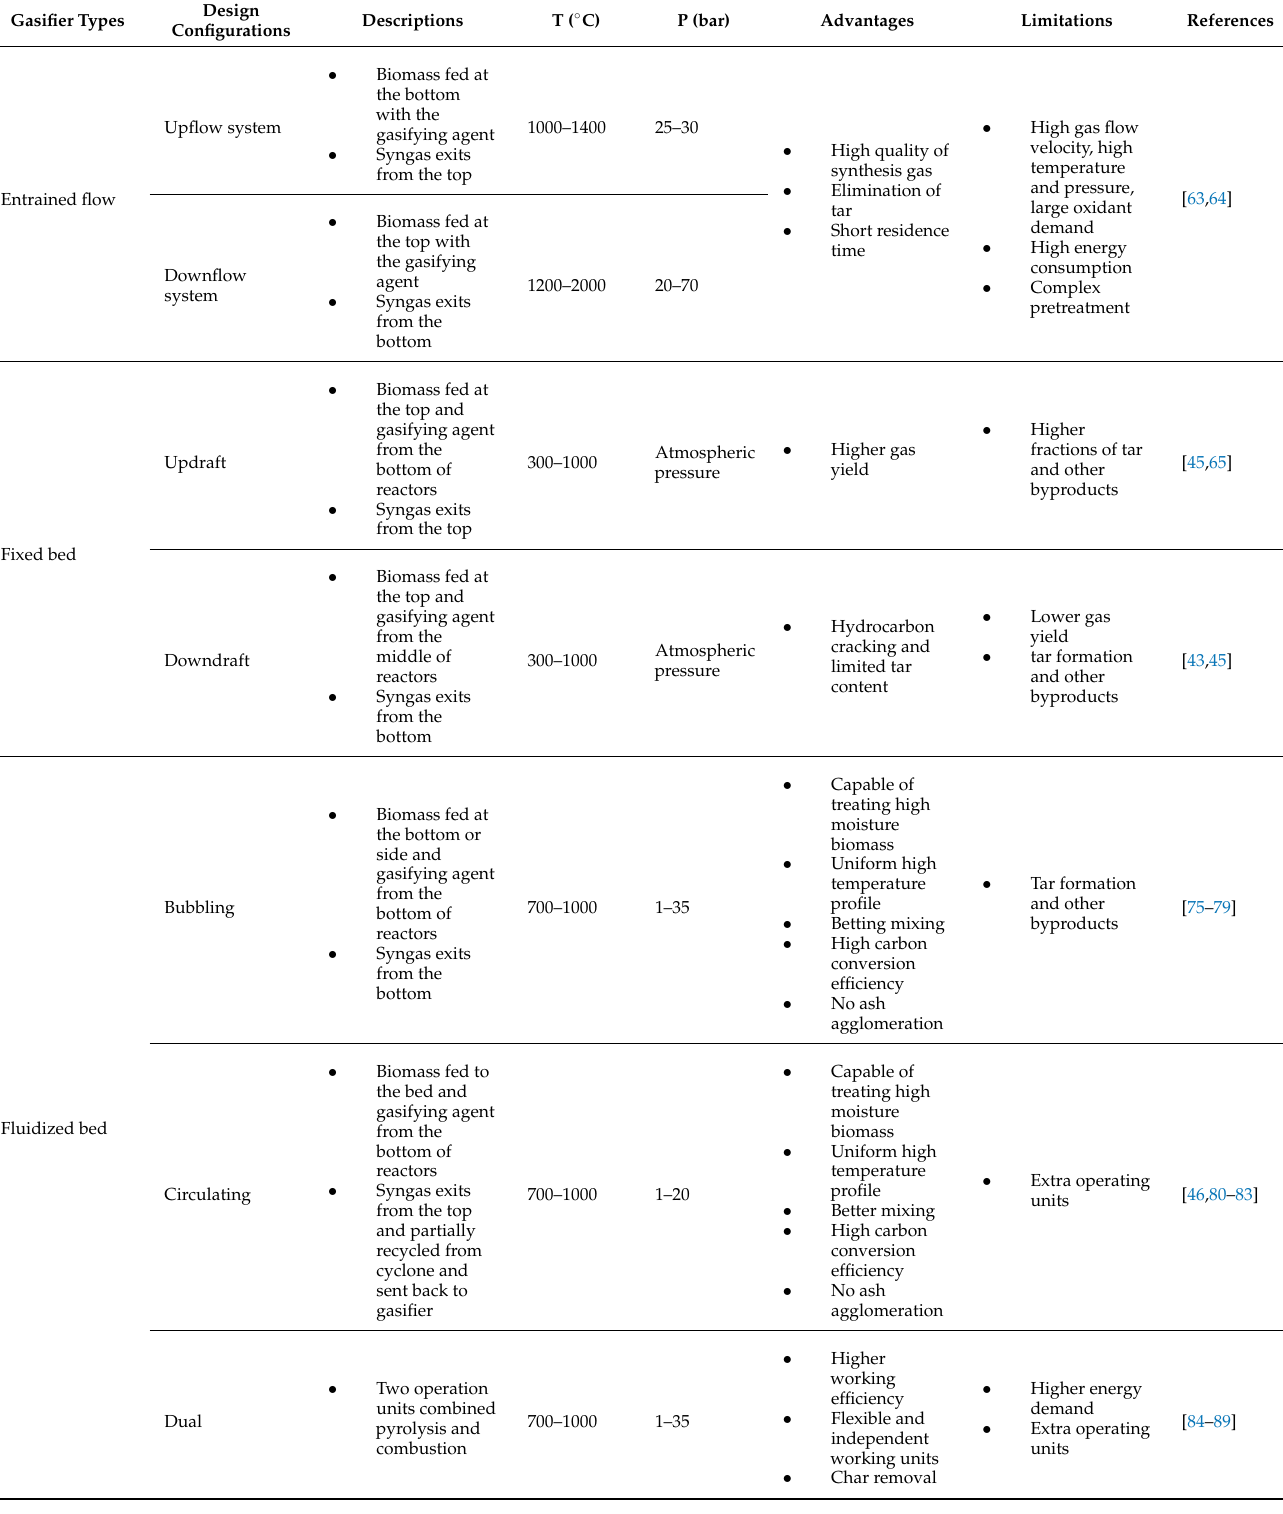
Table 2. Comparison of different types of gasifiers for biomass gasification including their operational conditions, advantages and